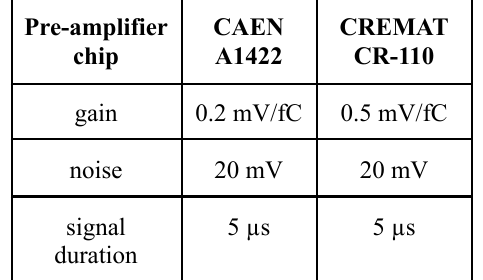
Table 2. Custom electronics' main features for the counting mode are